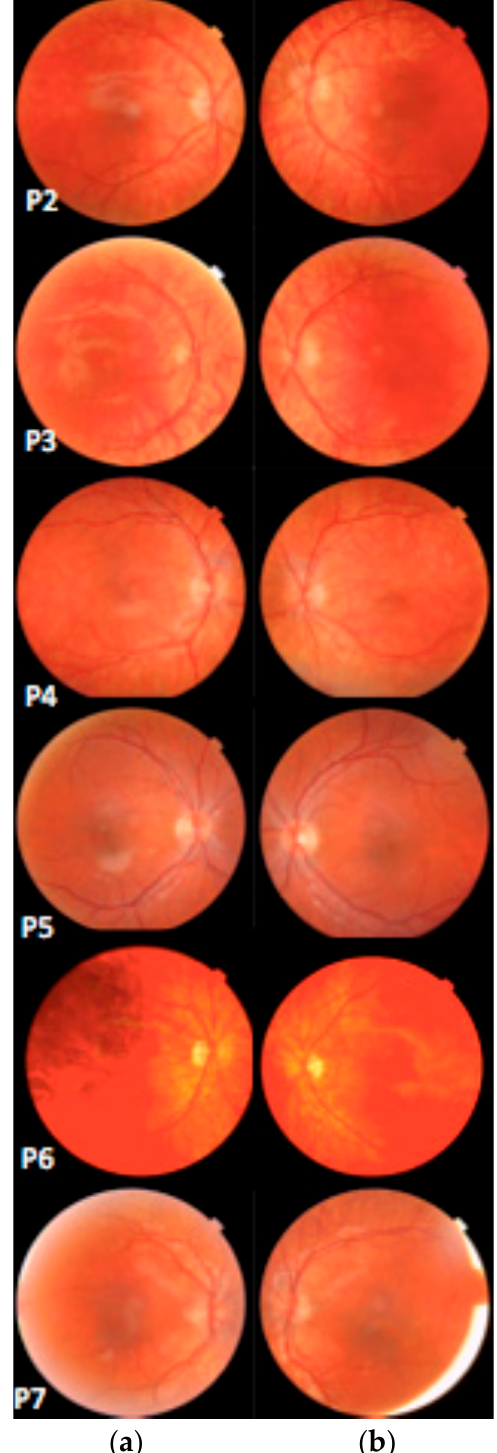
Figure 3. Fundus photography showing the degree of retinal hypopigmentation according to Krujit classification. ( a ) Right eye. ( b ) Left eye; (45° wide angle acquisition).